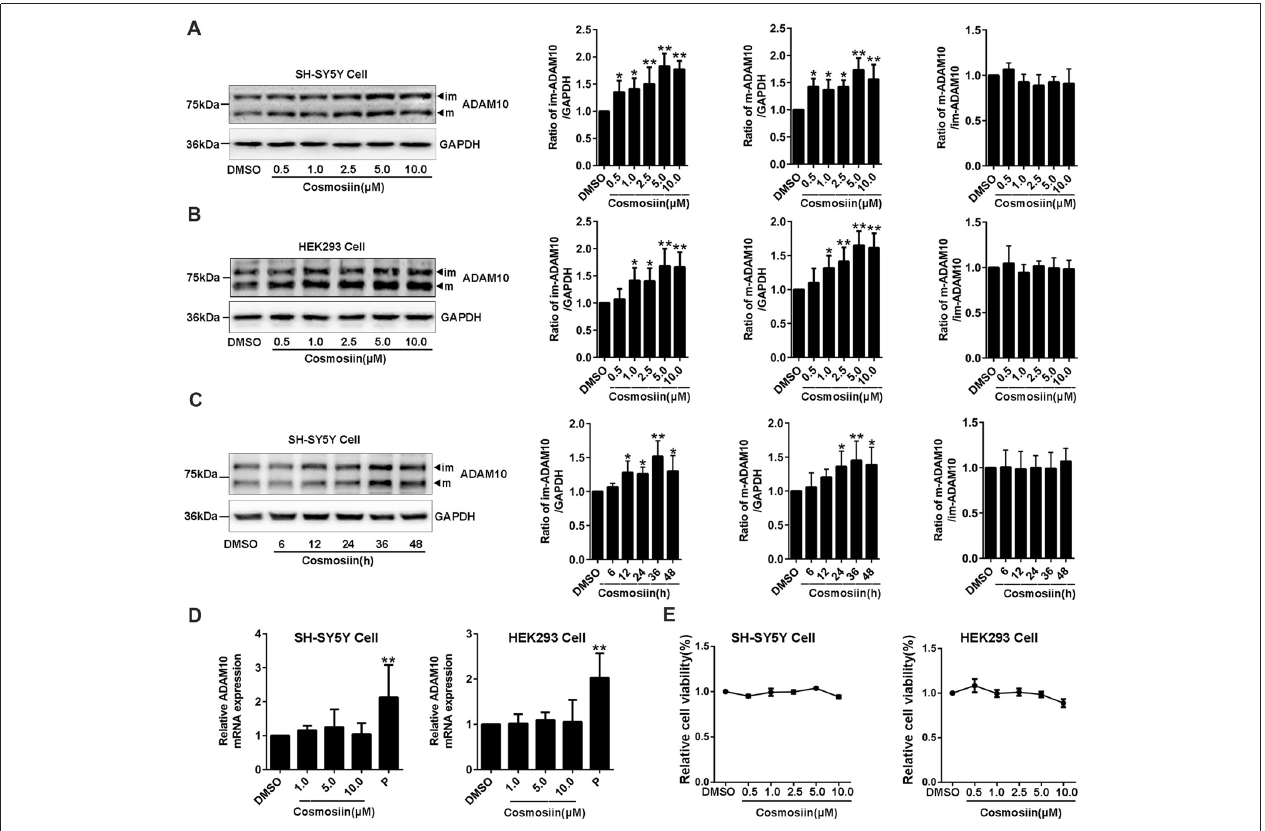
FIGURE 1 | Cosmosiin increases the levels of ADAM10 protein without altering its mRNA level. (A) Dose-response effect of cosmosiin on the levels of ADAM10 protein in SH-SY5Y cells. Representative Western blots (left) showing a band near 80 kD and a band near 60 kD, representing the immature (im) and mature (m) forms of ADAM10, respectively; procedures were conducted using SH-SY5Y cells treated with cosmosiin (at 0.5, 1, 2.5, 5 and 10 µ M) for 36 h (left). Bar plot summaries of im- and m-ADAM10 protein levels, and m-ADAM10/im-ADAM10 ratio, in the presence of cosmosiin (on the right). (B) Dose-response effect of cosmosiin on the levels of ADAM10 protein in HEK293 cells. Representative Western blots (left) and bar plot summaries (right) of the im-ADAM10 and m-ADAM10 protein levels, and m-ADAM10/im-ADAM10 ratio, in HEK293 cells treated with cosmosiin (0.5, 1, 2.5, 5 and 10 µ M) for 36 h. (C) Time-course effect of cosmosiin on the levels of ADAM10 protein. Representative Western blots (left) and bar plot summaries (right) of the m-/im-ADAM10 in SH-SY5Y cells treated with 5 µ M cosmosiin for indicated times (6, 12, 24, 36 and 48 h). (D) Relative ADAM10 mRNA levels in SH-SY5Y (left) and HEK293 (right) cells treated with cosmosiin (1, 5 and 10 µ M) and apicidin (P, 0.25 µ M) for 36 h. (E) Relative cell viability of SH-SY5Y (left) and HEK293 (right) cells treated with cosmosiin for 36 h. Data are expressed as means ± SD. ∗ P < 0.05; ∗∗ P < 0.01 ( n =